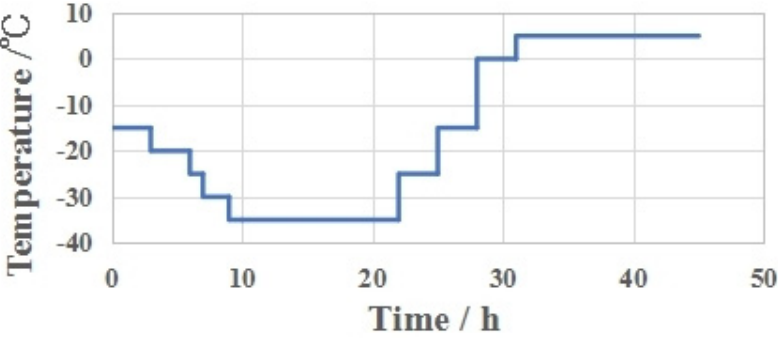
Figure 2. Freeze–thaw temperature control process.